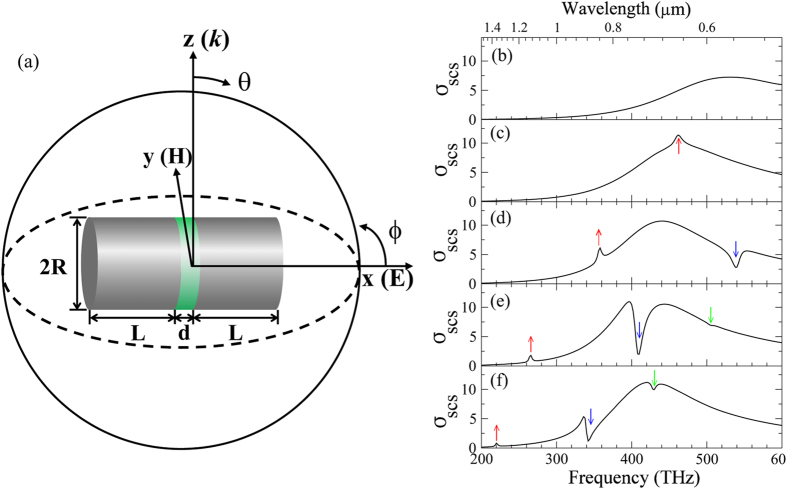
Schematic of the plasmonic dimer antenna and typical scattering spectra.(a) Schematic figure of the antenna and the excitation configuration. The scattering efficiency spectrum σSCS of a PDA with L = 90 nm, R = 50 nm, and d = 20 nm for (b) εload = 1, (c) εload = 3, (d) εload = 6, (e) εload = 12, and (f) εload = 18.